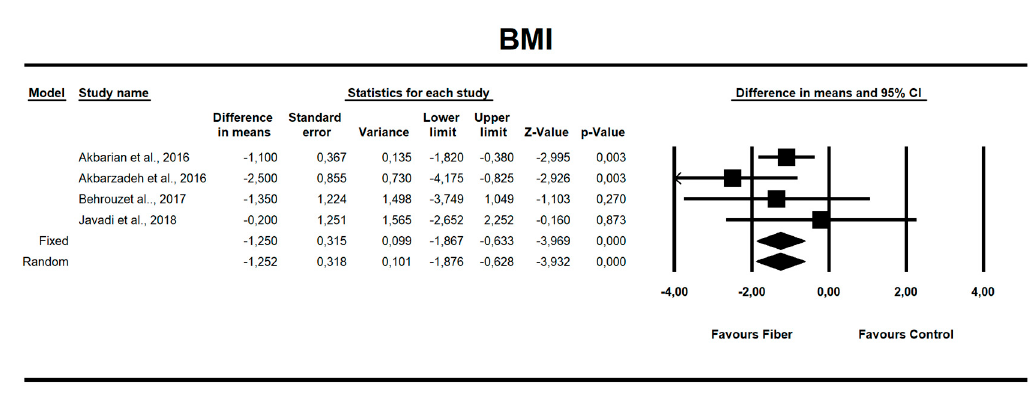
Figure 3. Effect size and difference in means (DM) for BMI in people supplementing fiber vs. controls. Q = 3.018, df(Q) = 3, p = 0.389, I-squared = 0.588.